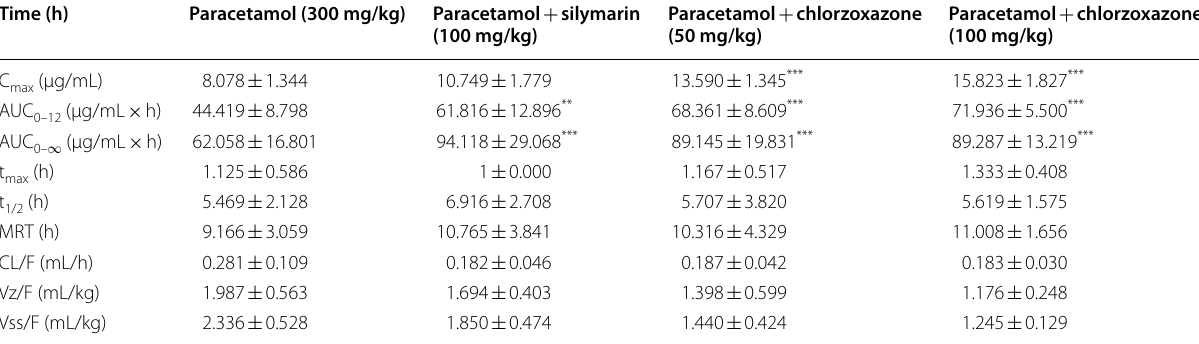
Table 1 Pharmacokinetic parameters of Paracetamol (300 mg/kg) following an oral administration of Paracetamol to rats with or without silymarin (100 mg/kg) and chlorzoxazone (50 and 100 mg/kg)